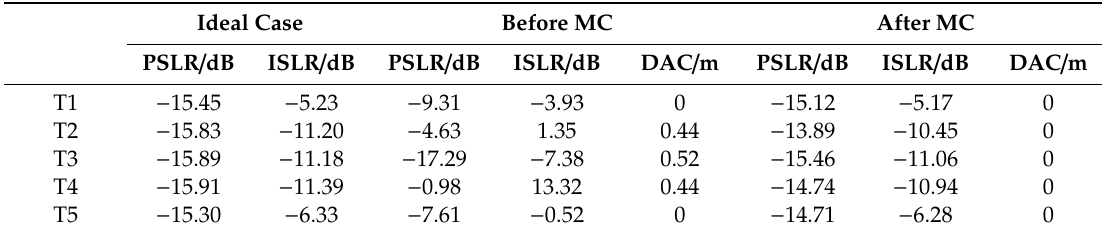
Table 4. Quality parameters with the sawtooth perturbation.